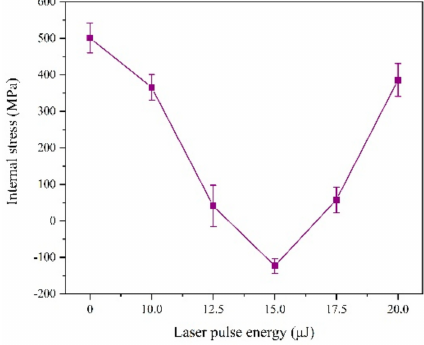
Figure 7. Internal stress of coatings with varying laser